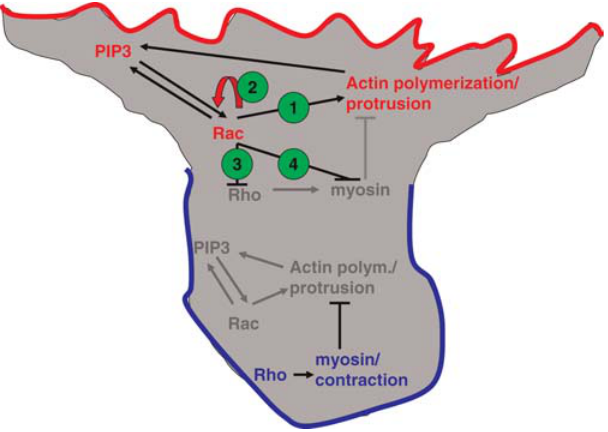
Figure 8. Role of Leading Edge Complexes in Cell